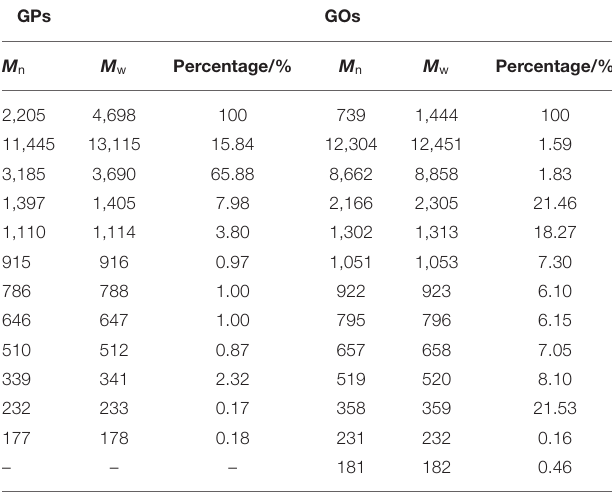
TABLE 1 | The molecular weight distribution of GPs and GOs.